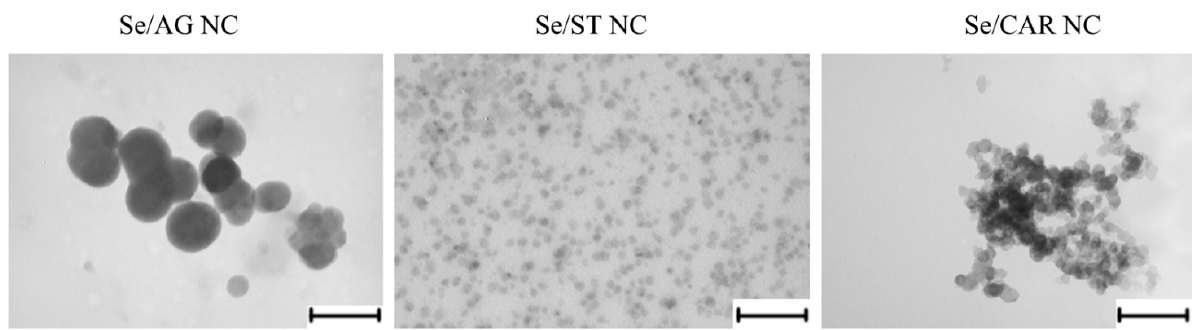
Figure 6. Photos of the Se NCs obtained using a transmission electron microscope LEO 906E. Scale bar = 200 nm.